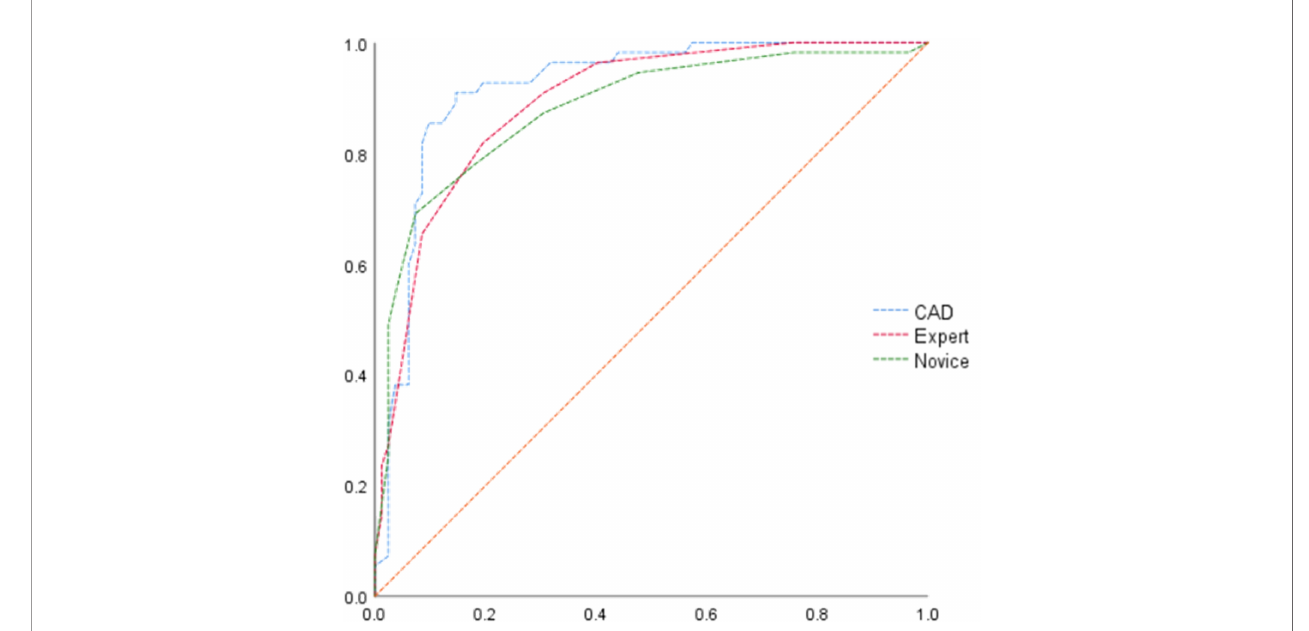
FIGURE 3 | ROC curves of the CAD system, expert, and novice for US diagnosis of thyroid nodules.